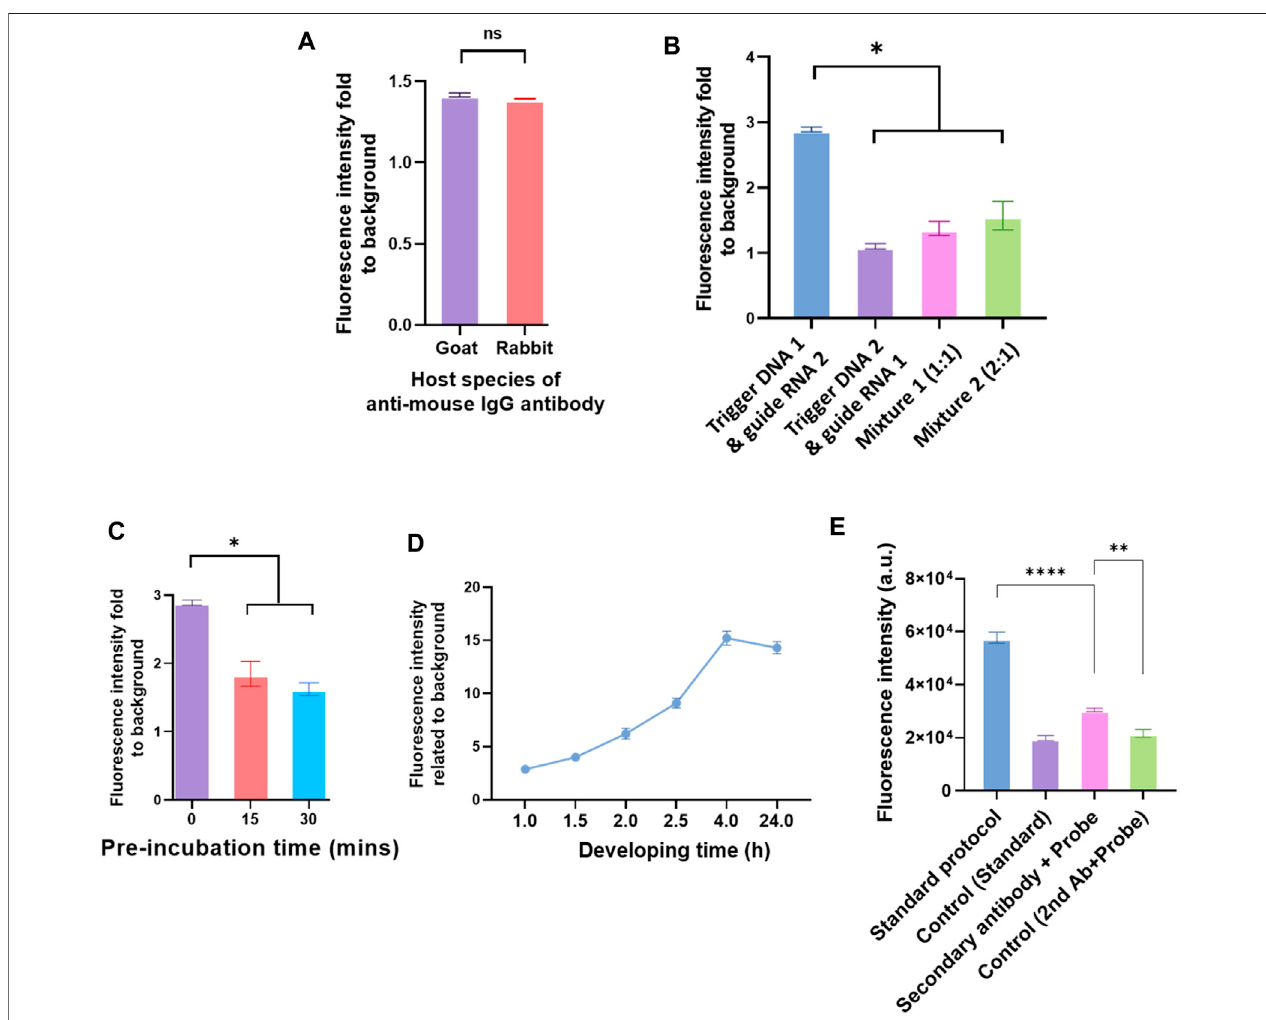
FIGURE 5 | Different elementsin the IgG – ssDNA probe conjugation and elementsin the Cas12a reaction mix affectthe detection of analytes by CRISPR/Cas12a- assisted new immunoassay (CANi). (A) Detection ef fi ciency of probe conjugated with different host species of anti-mouse IgG antibodies. (B) In fl uence of triggering ssDNA and guiding RNA sequences on detecting the analytes by CANi. The sequences of triggering ssDNA and guiding RNA were listed in the supplementary information Supplementary Table S1 . Mixture 1 was mixed triggering ssDNAs 1 and 2 with ratio 1:1, and mixture 2 was mixed triggering ssDNAs 1 and 2 with ratio 2:1. (C) Preincubation decreased the ef fi ciency of detecting the analytes. (D) Cas12a reaction time, ranging from 1 to 24 h. (E) Detection ef fi ciency of adding the detection antibody and probe separately or adding the complex of detection antibody and probe. * indicates signi fi cant differences ( p < 0.05), ** indicates signi fi cant differences ( p < 0.005), and **** indicates signi fi cant differences ( p < 0.0001) analyzed by two-way ANOVA.